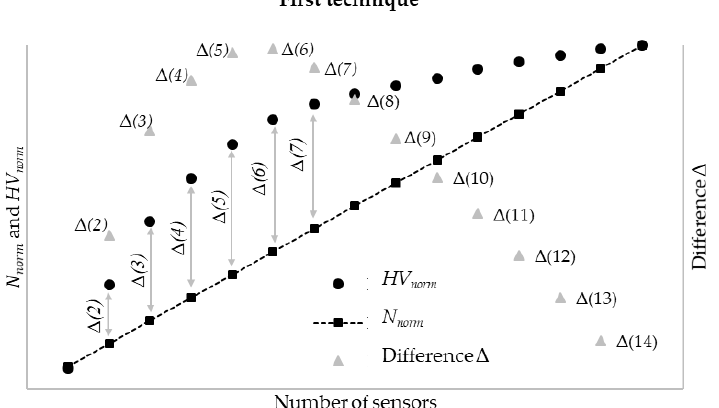
Figure 3. Determination of the optimal number of sensors based on the evolution of the hypervolume by using the Kneedle method.